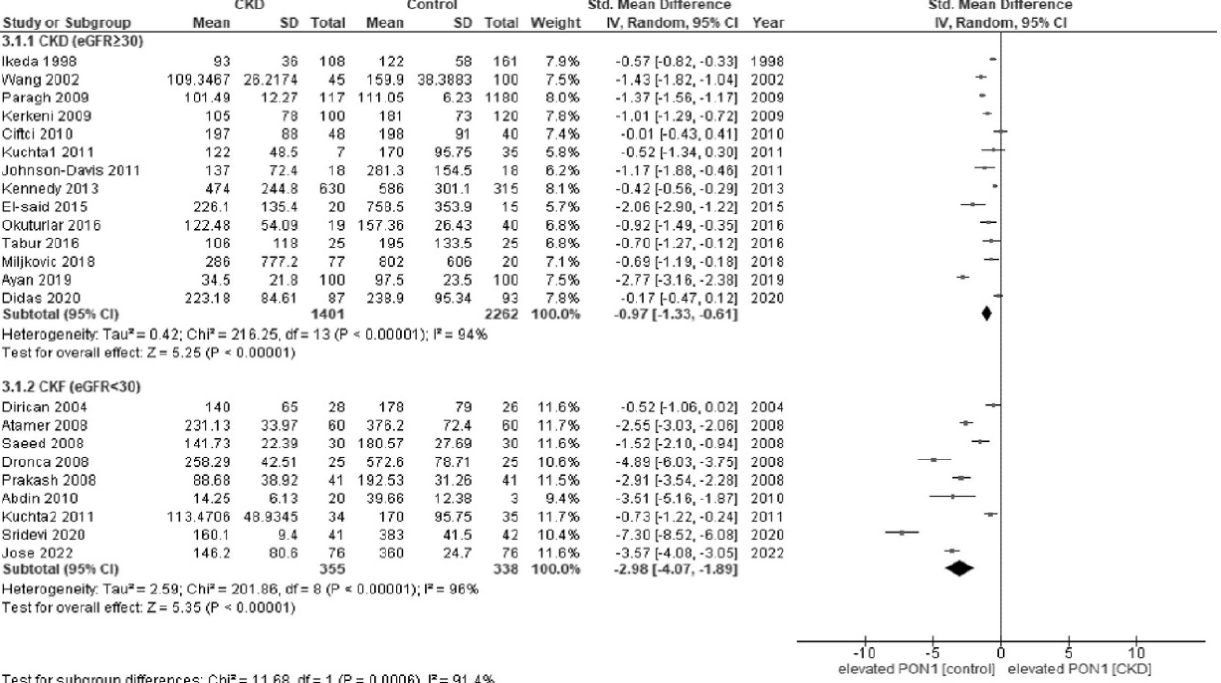
Figure 4. Forest plot of paraoxonase activity stratified by the CKD stages